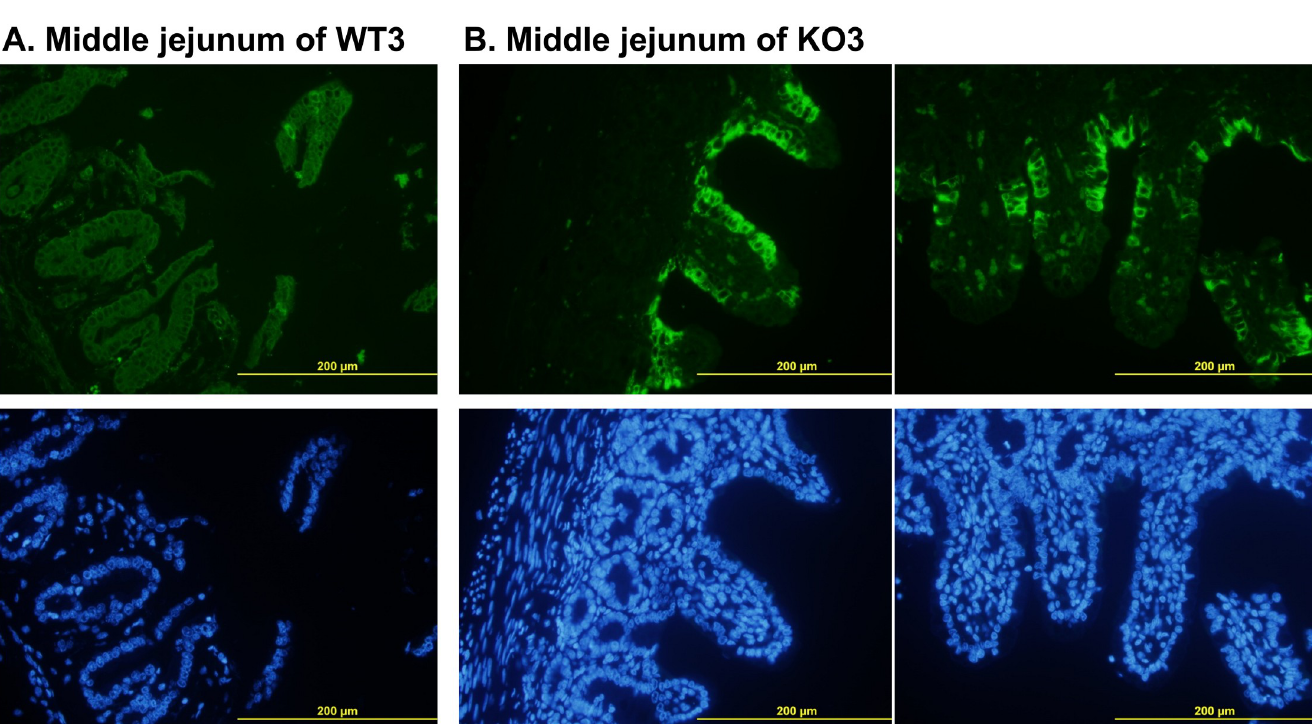
Fig 9. Immunofluorescence staining with an antibody against nv-PEDV N protein. WT3 (A) shows a sample from a wild-type piglet, and KO3 (B) shows a sample from a double-chromosome CMAH gene knockout piglet. The samples shown in the upper, green colour, and lower, blue colour, panels are fluorescent stained with nv-PEDV antibody and DAPI, respectively. The yellow bars indicate 200 μ m.